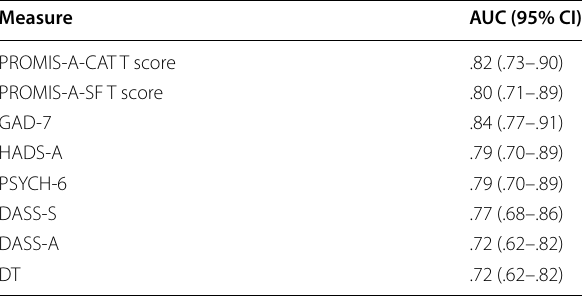
Table 2 Area under the curve (AUC) for each measure versus diagnosis of any anxiety disorder using the structured clinical interview for DSM disorders